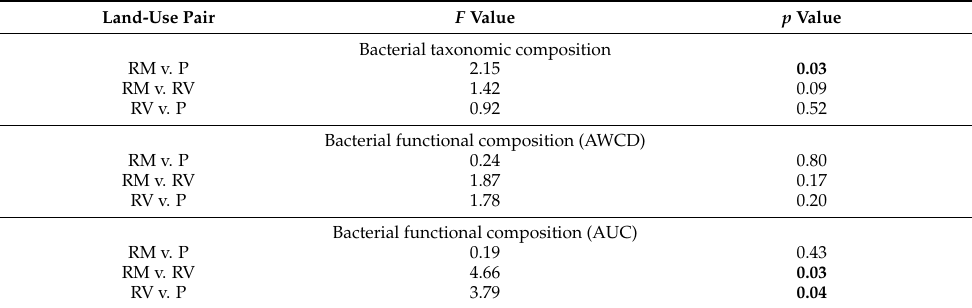
Table 4. PERMANOVA pairwise comparisons for each land-use combination, p values < 0.05 are in